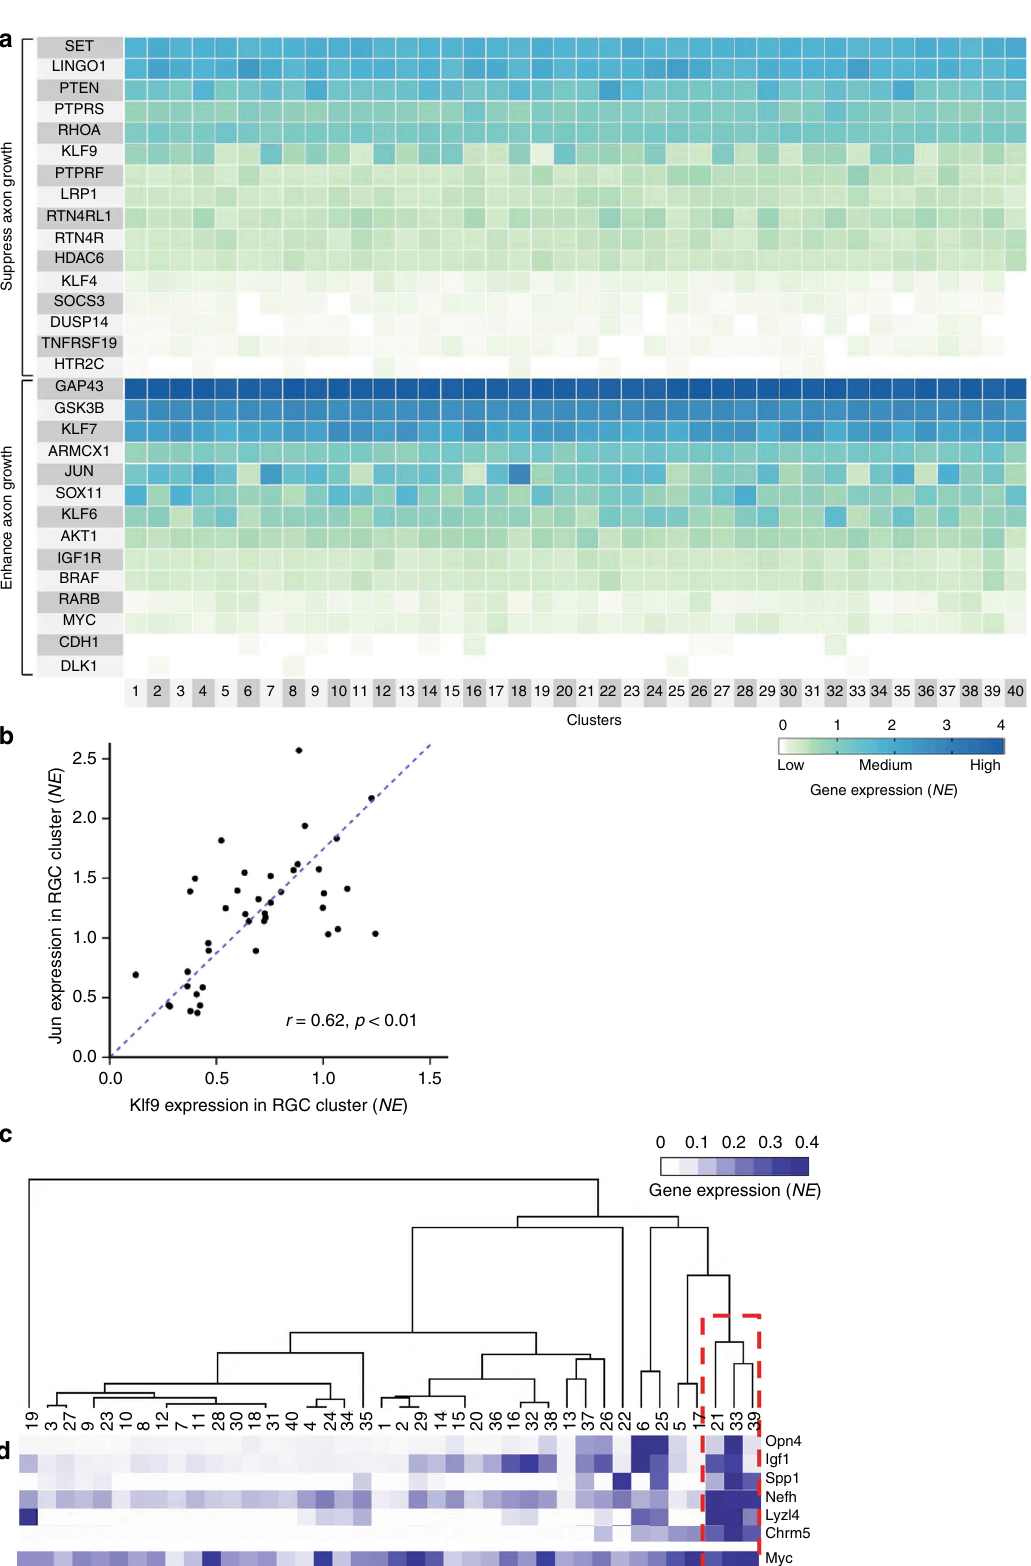
Fig. 9 RGC subtypes enriched for axon growth-regulating genes. a Heatmap of genes known to regulate axon growth and regeneration shows differential expression between RGC subtypes. b Correlation between enrichment of Klf9 and Jun genes expression in different RGC subtypes, r = 0.62, p < 0.01 (Pearson, 2-tailed). c Heatmap of genes enriched in melanopsin-expressing ipRGCs, and a dendrogram showing clustering of putative α RGC subtypes (red box). d Myc gene is highly expressed in putative α RGC